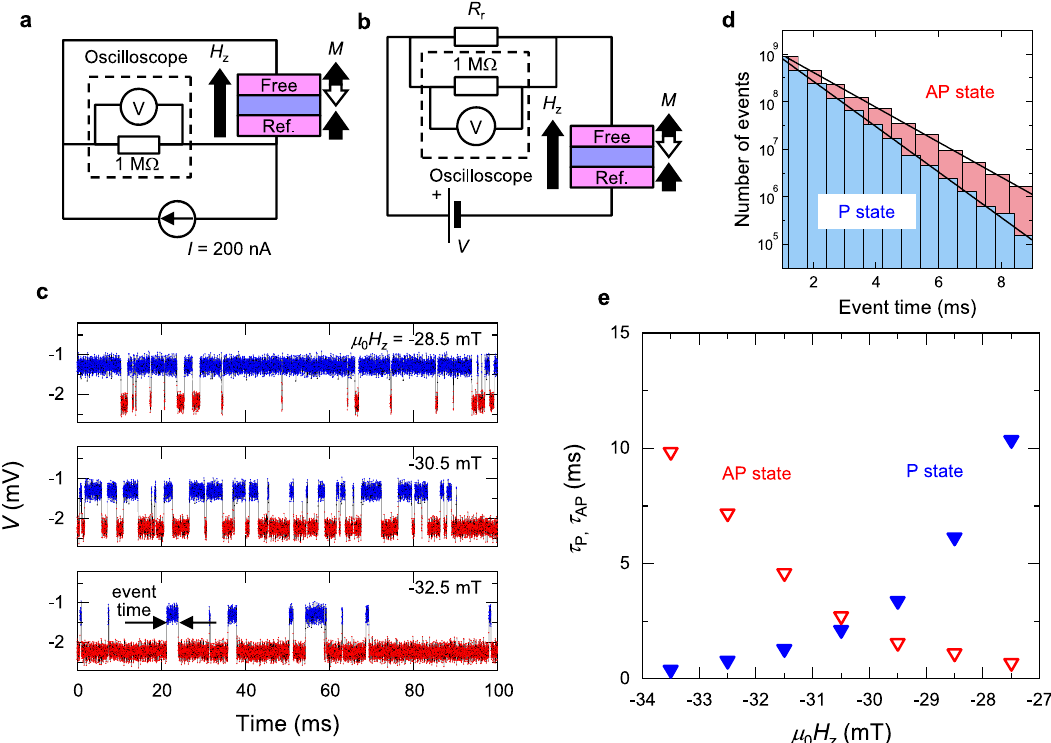
Fig. 4 Random telegraph noise. a , b Circuit con fi guration to measure random telegraph noise (RTN) with V ~ 0 and V ≥ 25 mV, respectively. c Typical RTN signal monitored at the oscilloscope. d Histogram of event time (duration between two sequential switching events) for P and AP states for μ H = − 30.5 mT. e Expected switching time as a function of perpendicular magnetic fi eld H z 0